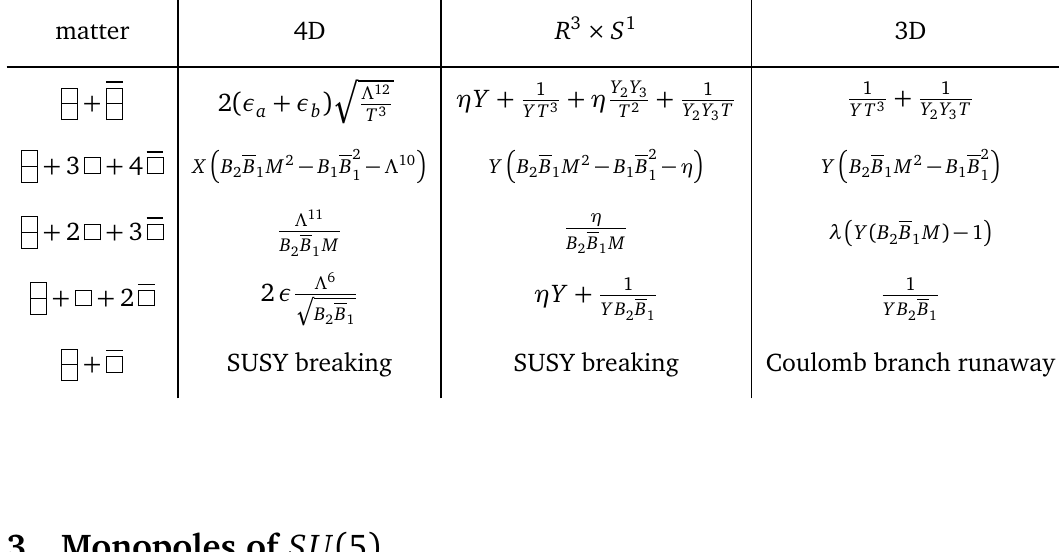
matter 4D R 3 × S